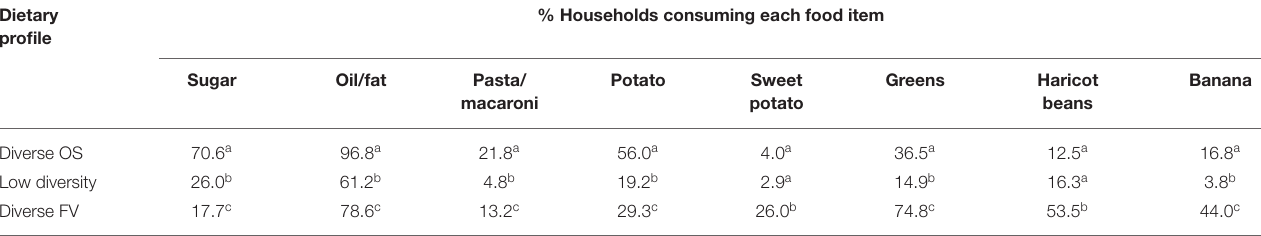
TABLE 2 | Percentage of households consuming various food items within the past 7 days by dietary profile. Dietary profile